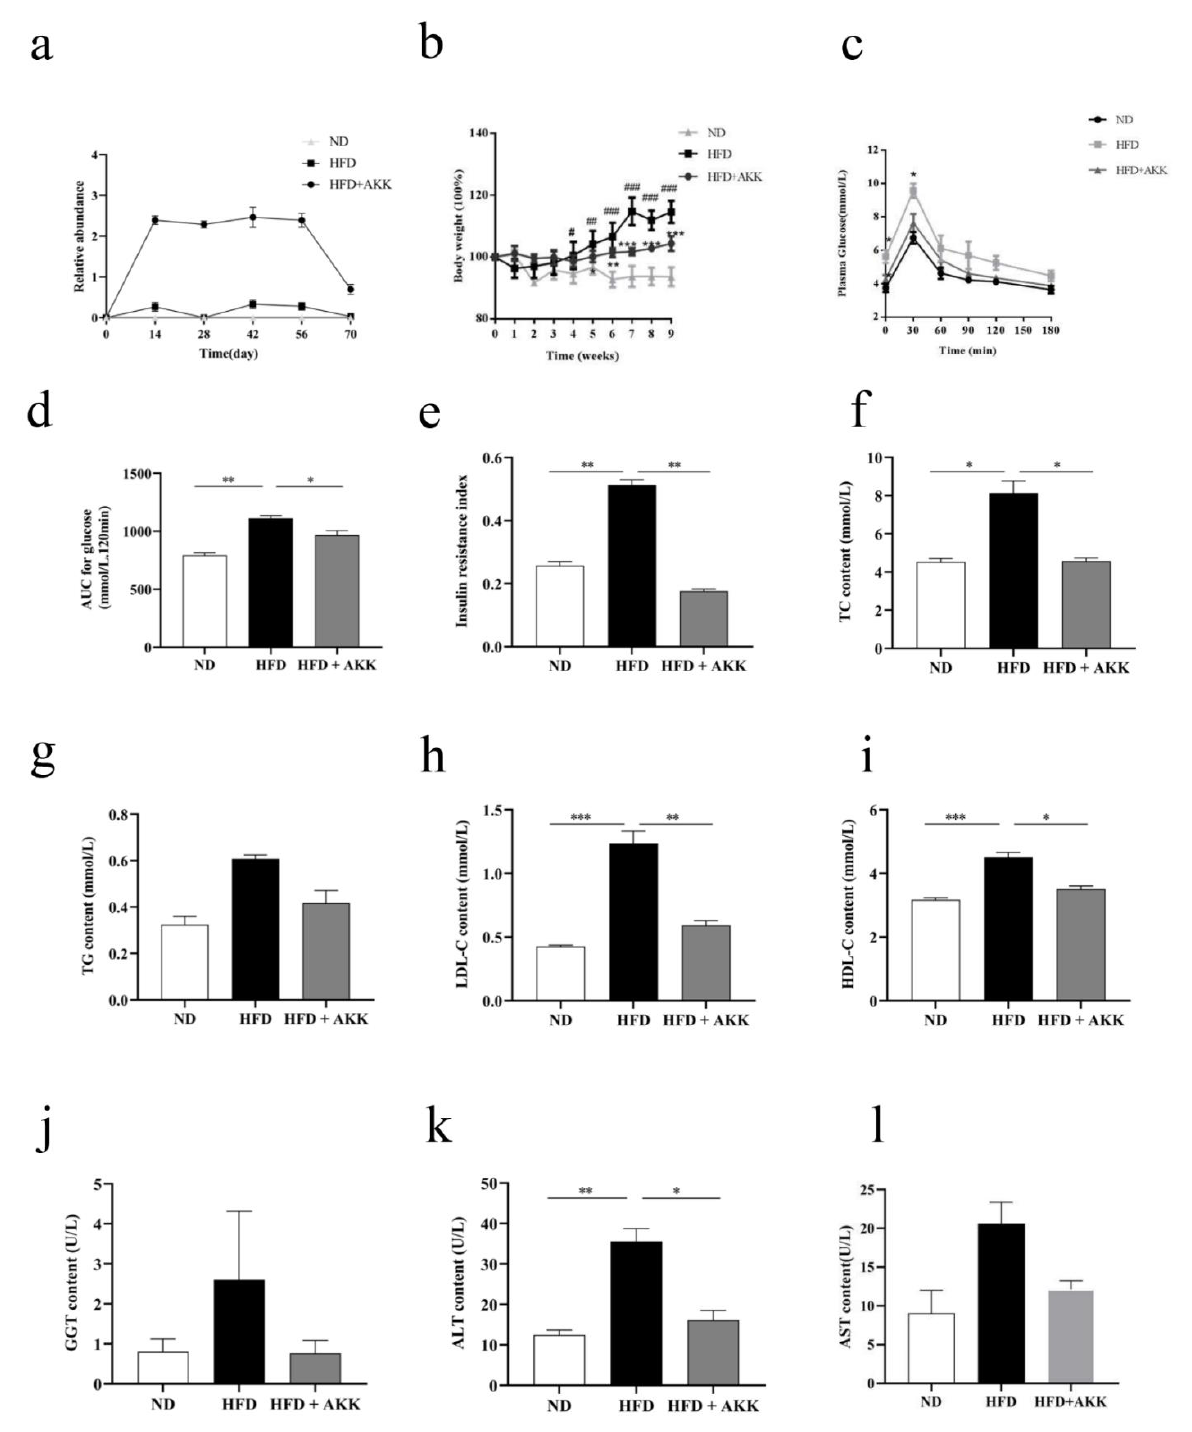
Figure 3. A. muciniphila AKK2 reduced body weight and improved metabolism in HFD-induced beagles. ( a ) relative abundance of A. muciniphila in dog gastrointestinal tract. ( b ) body weight measured weekly (data expressed as % of initial body weight). ( c ) serum glucose levels at different time-points and ( d ) area under the curve (AOC) in oral glucose tolerance tests (OGTT). ( e ) insulin resistance index. ( f ) serum level of total cholesterol (TC). ( g ) triglyceride (TG). ( h ) LDL cholesterol (LDL-C). ( i ) HDL cholesterol (HDL-C). ( j ) transglutaminase (GGT). ( k ) alanine aminotransferase (ALT). ( l ) aspartate aminotransferase (AST) for different experimental groups. The data are pre- sented as the mean ± SEM ( n = 8). Statistical analyses were performed with one-way ANOVA test. * p < 0.05, ** p < 0.01 and *** p <